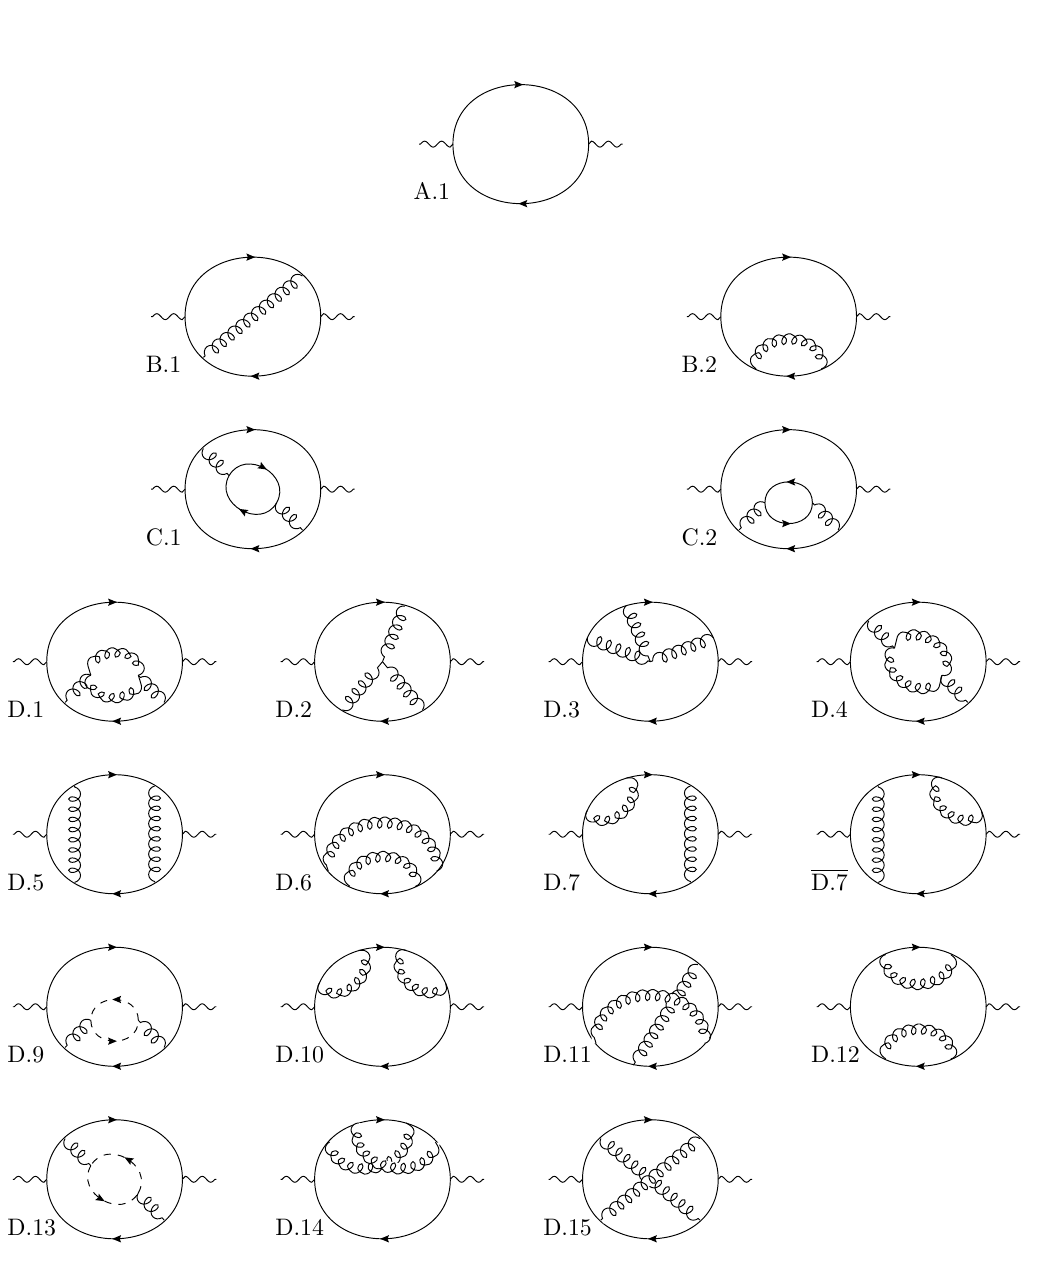
Figure 12. All contributing supergraphs to the class of processes γ ? → jj + X and γ ? → t ¯ t + X at LO (A.1), NLO (B.i) and NNLO (C.i and D.i). The outer fermion loop is set massless for γ ? → jj + X and massive with mass m t for γ ? → t ¯ t + X . The NNLO contribution proportional to n only comes from the two supergraphs C.1 and C.2, when the inner fermion loop is always f considered massless. We note that supergraphs D.7 and D.7 are isomorphic, but we chose to report them separately here because the symmetry from exchanging the two identical external off-shell photons was not considered at generation